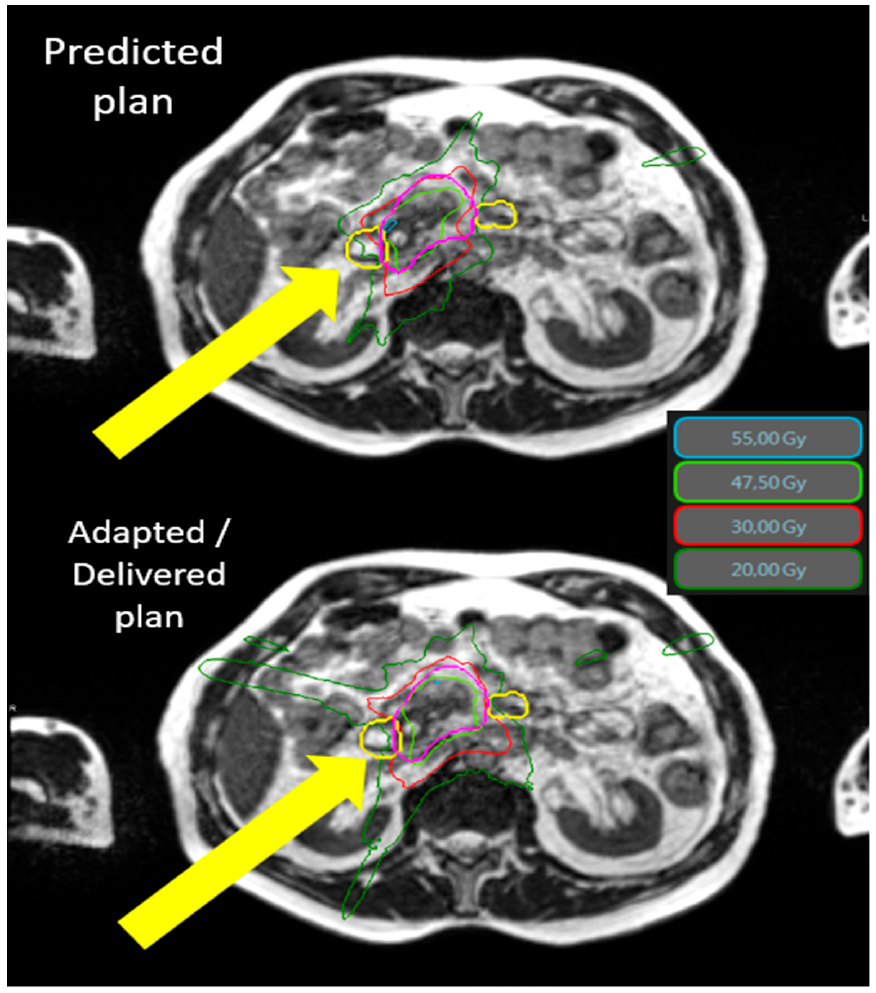
Figure 1. Typical SMART dosimetry showing the predicted and adapted/delivered dosimetry for locally advanced pancreatic cancer. An example of the dosimetric benefit between the predicted plan ( top ) and the adapted plan ( bottom ). The yellow arrows demonstrate the protection of the duodenum (yellow line) by the adaptive process. The 55 Gy (cyan) and 30 Gy (thin red line) isodoses no longer cross the duodenum in the lower image. Isodose 55 Gy in cyan, 47.5 Gy in green, 30 Gy in red, and 20 Gy in dark green. The duodenum is in yellow and PTV is in pink. Abbreviations: Gy = gray 3.4. Toxicities. Table 4. SMART-related acute and late